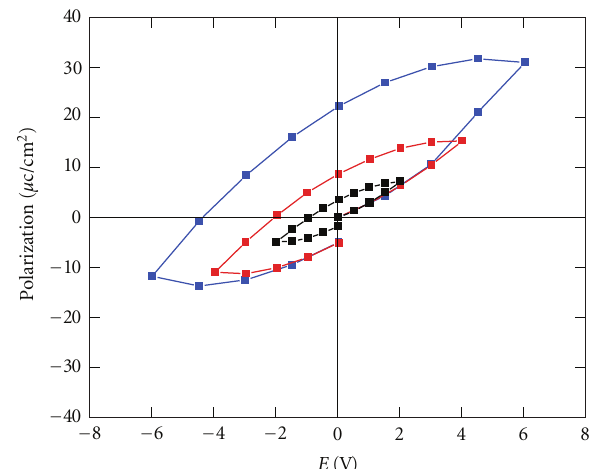
Figure 4: Polarization versus applied electrical field of an annealed BTO-MZF nanocomposite film, di ff erent voltages of 2V, 4V, and 6V were